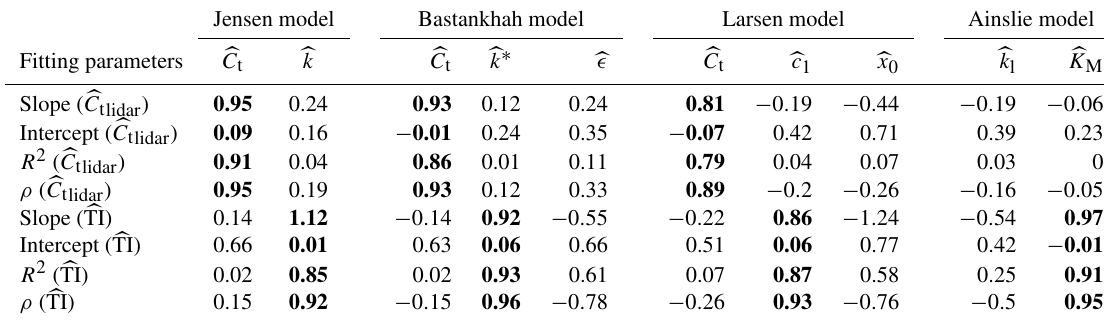
Table 1. Linear regression between inputs from lidar cluster and output parameters from the wake models. Bold values indicate high corre- lation between the respective parameters. Jensen model Bastankhah model Larsen model Ainslie model Fitting